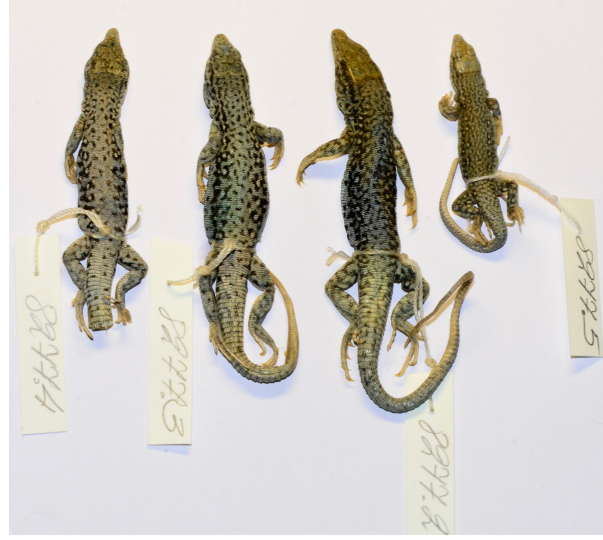
Figure 4. Paratypes of Eremias kokschaaliensis B (ZISP 8277) in preservative in dorsal view.